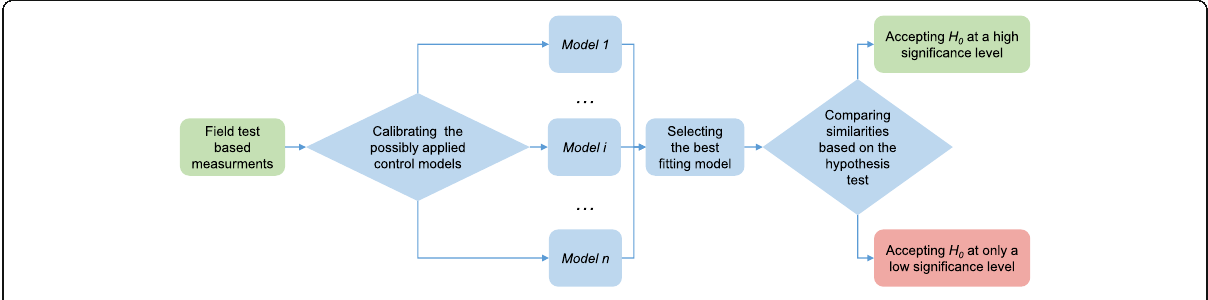
Fig. 6 the proposed framework of evaluating automated vehicle